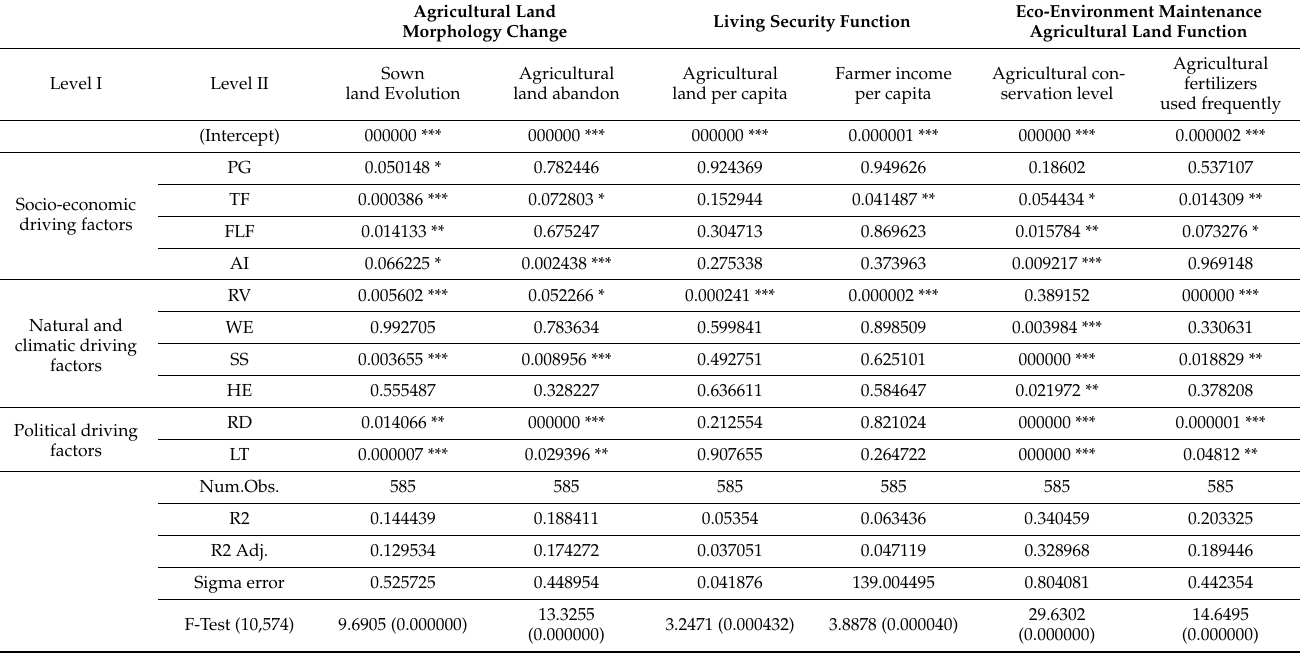
Table 6. The regression analysis results for agricultural land use and its influencing